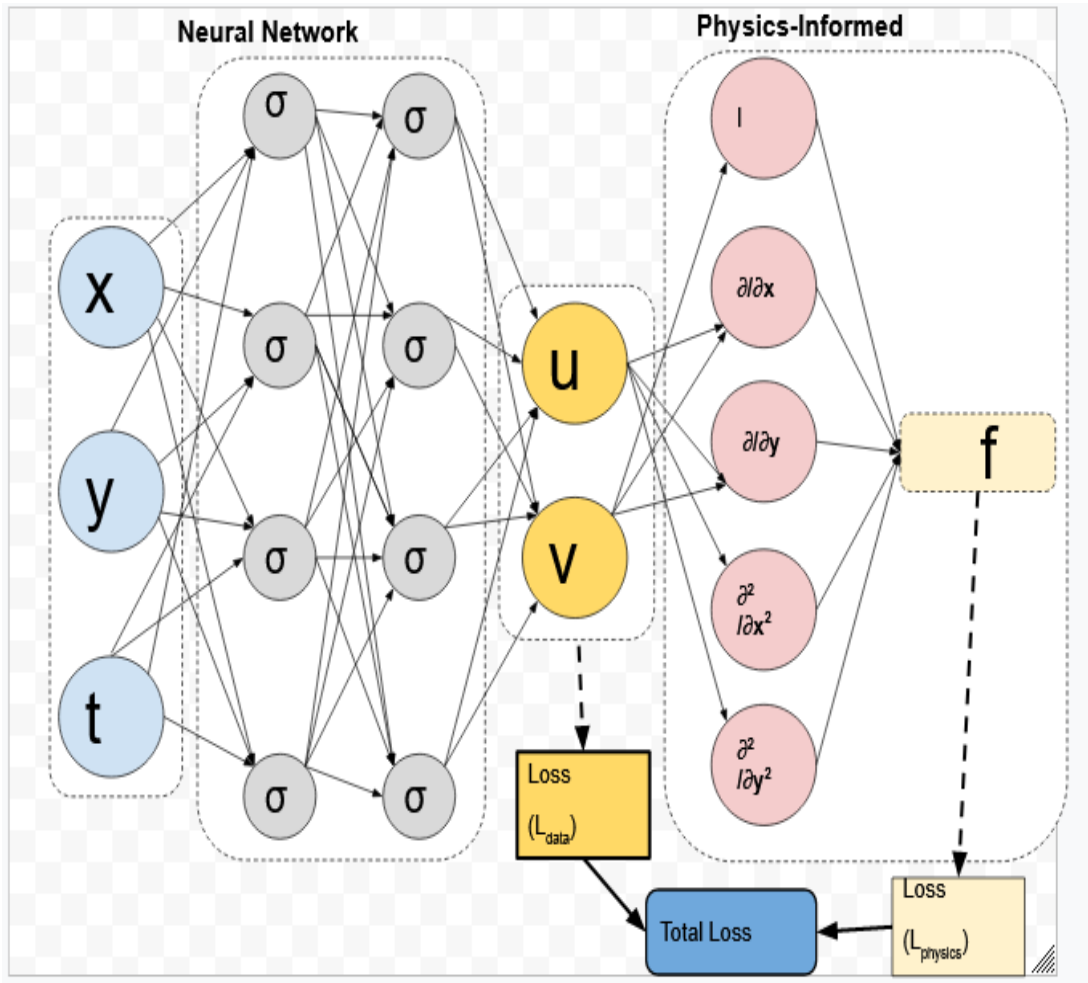
Figure 1. Schematic diagram of a PINN. Adapted with permission from Ref. [91]. Copyright 2021 De Wolff, Carrillo, Martí, and Sanchez-Pi.